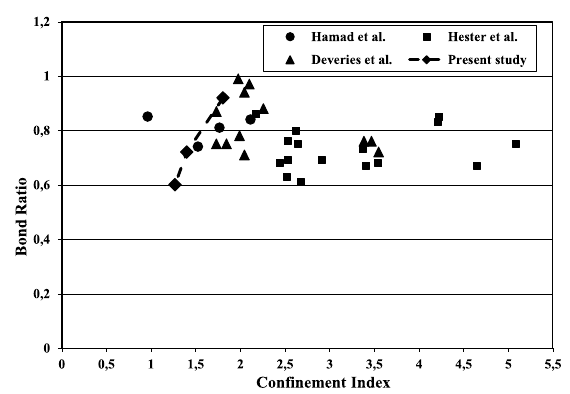
Figure 11. Effect of confinement on bond